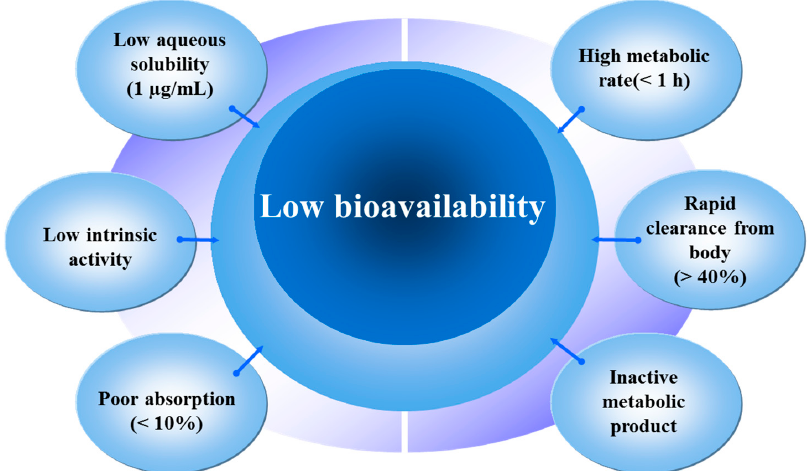
Figure 3. Limitations of quercetin as an anti-cancer drug.